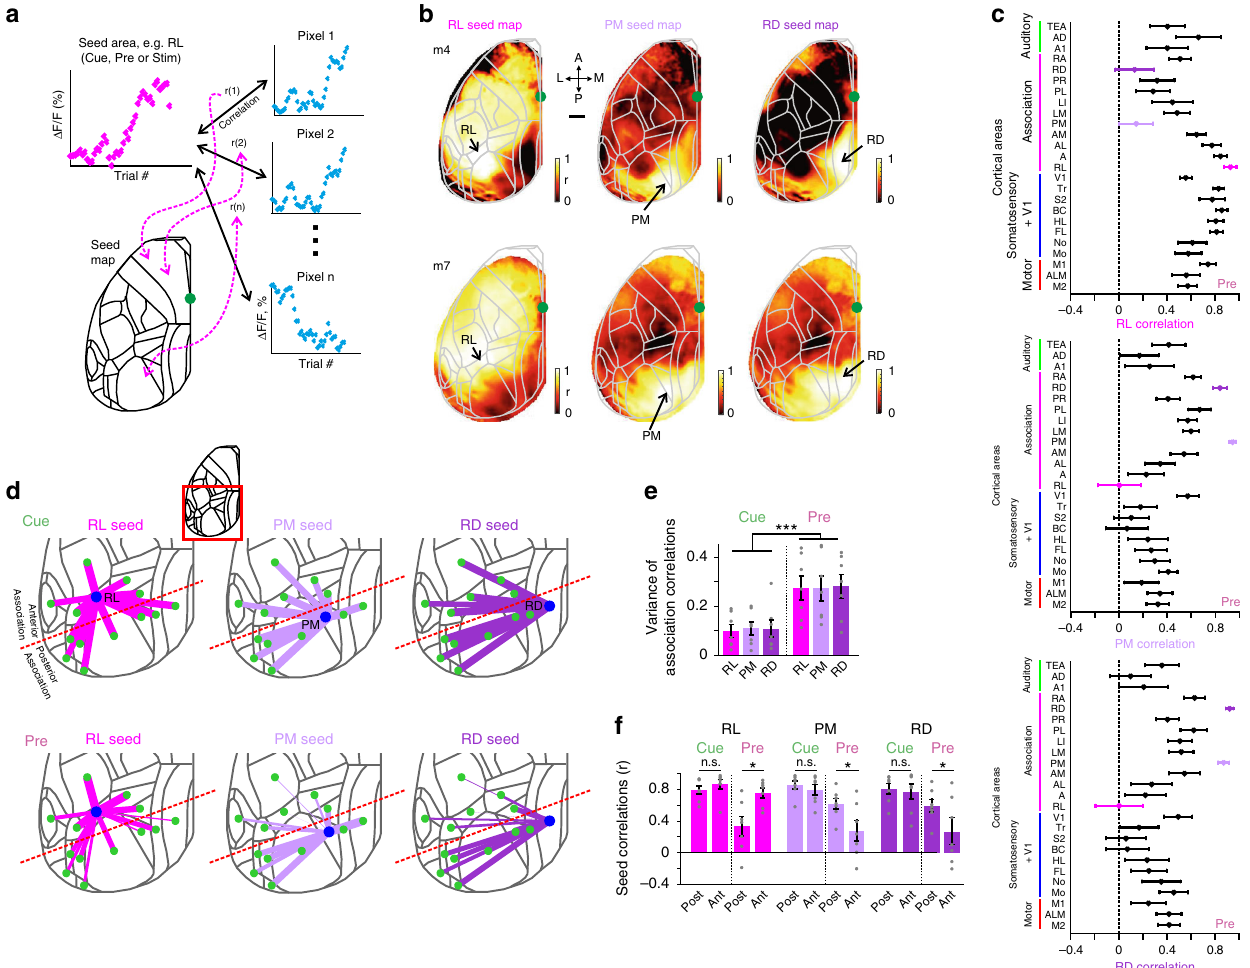
Fig. 6 Functional reorganization of association cortex during learning. a Schematic of calculating a seed correlation map. Each pixel in the map re fl ects the correlation coef fi cient ( r ) between the learning-related Δ F / F curve of a seed area (e.g. RL, PM, or RD) and the learning-related Δ F / F signal changes of the respective pixel. Seed maps can be calculated separately for cue-, pre-, or stim-period. b Seed maps for RL, PM, and RD during pre-period in two example mice. Color denotes r-values. Scale bar is 1 mm. c Correlation between the three seed areas and all the other areas during pre-period, averaged across all mice. Error bars are s.e.m. across mice. d 2D overview of the inter-areal correlations across learning during cue- (top) and pre-period (bottom) between RL (left), PM (middle), and RD (right) and the surrounding cortical areas (also including A1, BC, and V1). Line width is proportional to the average r-value across all mice. Red dashed line indicates separation into anterior and posterior association areas. e Variance of inter-areal correlations within all association areas for each seed area in cue- and pre-period. Error bars are s.e.m. across mice. Gray dots depict individual mice. f Seed area correlation values for the three areas during cue- and pre-period, averaged separately for anterior or posterior association areas. Error bars are s.e.m. across mice. Gray dots depict individual mice. * P < 0.05. *** P < 0.001. n.s. not signi fi cant. Wilcoxon signed-rank